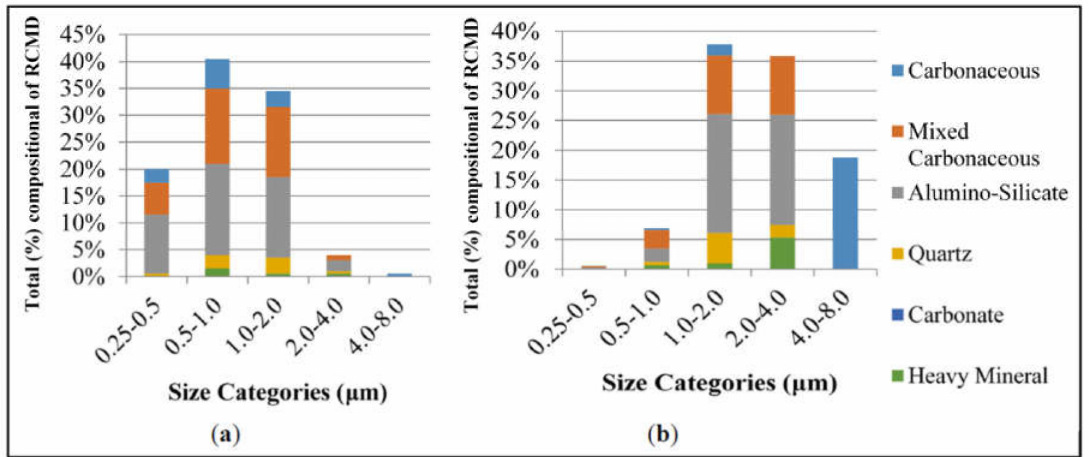
Figure 4. Particle size distribution by ( a ) number and ( b ) mass for the roof bolter sample (roof bolting machine); the relative number of particles in each compositional category is shown within each bar [62]. RCMD samples were collected from an underground coal mine in central Appalachia using a CMDPSU on 37 mm diameter polycarbonate filters. The center portion (9-mm diameter) of the filter was cut and attached to an SEM pin-stub for